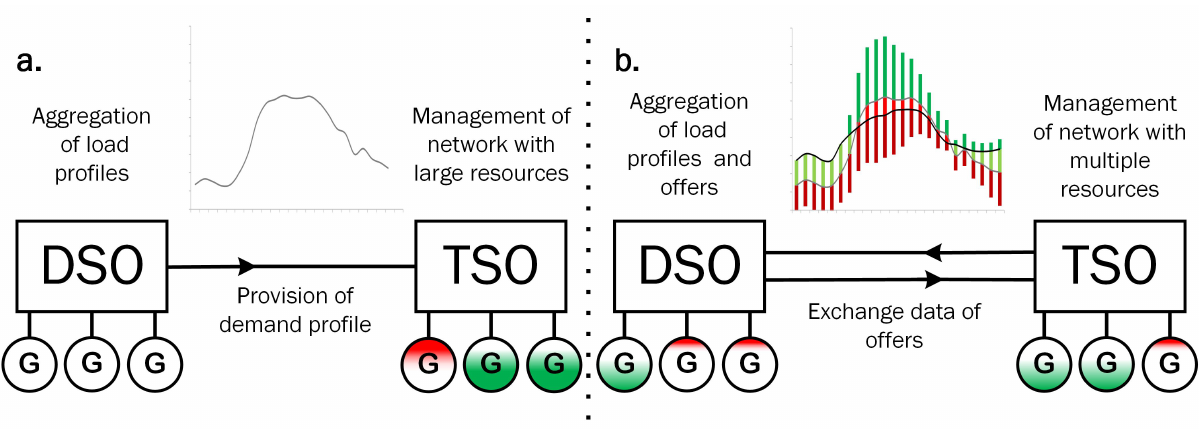
Figure 1. Coordination strategy between TSO and DSO. The red color in the generator reflects a reduction of power output in dispatch, a green increase of power output in dispatch, whereas white represents a lack of ability to coordinate specific sources. ( a ) Current approach. ( b ) New